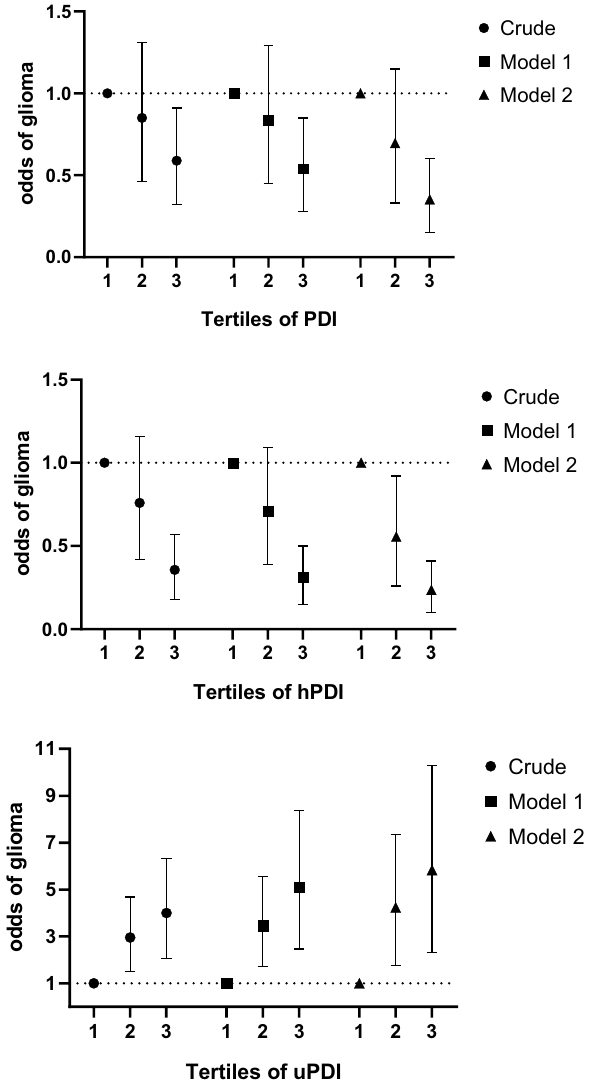
Figure 1. Crude and multivariable-adjusted odds ratios and 95% CIs of glioma by tertiles of different plant- based diet index. Model 1: adjusted for age, sex, and energy intake. Model 2: further adjustments were made for physical activity, family history of glioma, marital status, high-risk job, high-risk living area, duration of cell phone usage, supplement use, history of exposure to the radiographic X-ray, history of dental photography, history of head trauma, smoking status, exposure to chemicals, personal hair dye use, frequent use of fried food, and